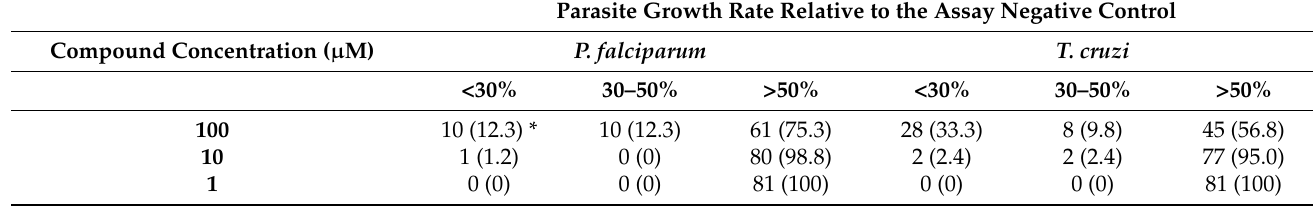
Table 1. Number of compounds classified according to the percentage of parasite growth in the primary screening. Parasite Growth Rate Relative to the Assay Negative Control Compound Concentration ( µ M)